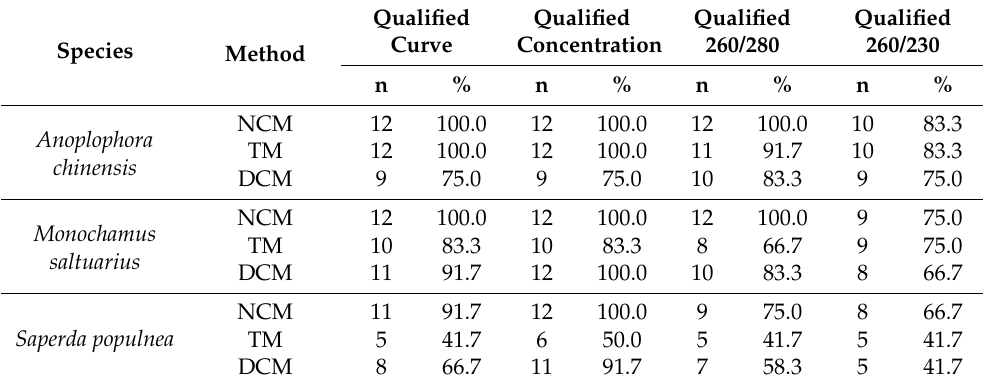
Table 1. Quality indexes of dissolution profiles for three species of cerambycid beetles under different collection methods (N = 12).